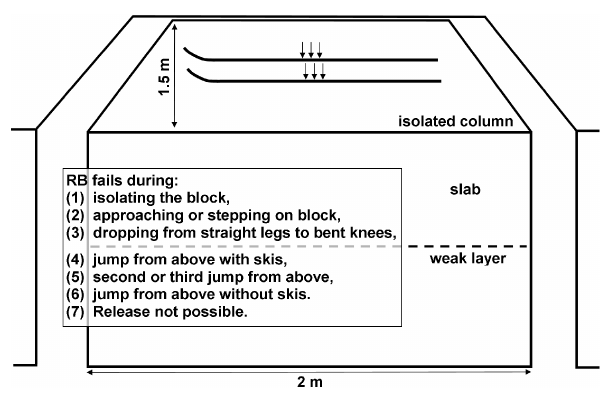
Figure 1. Sketch presenting the rutschblock (RB) test as it is seen looking upslope: after isolating a block of snow 2m wide and 1.5m upslope it is loaded progressively by a skier. The loading steps and scores are described in the inset. The release type was not consid- ered here.